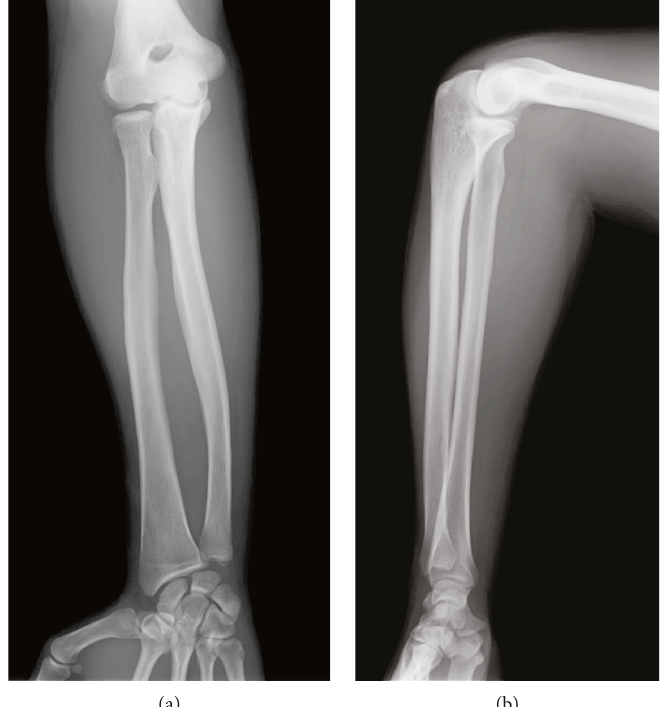
Figure 6: X-rays 21 years after surgery. (a) Front view. (b) Lateral view. The compatibility of the radiocapitellar joint was good, and no malunion was